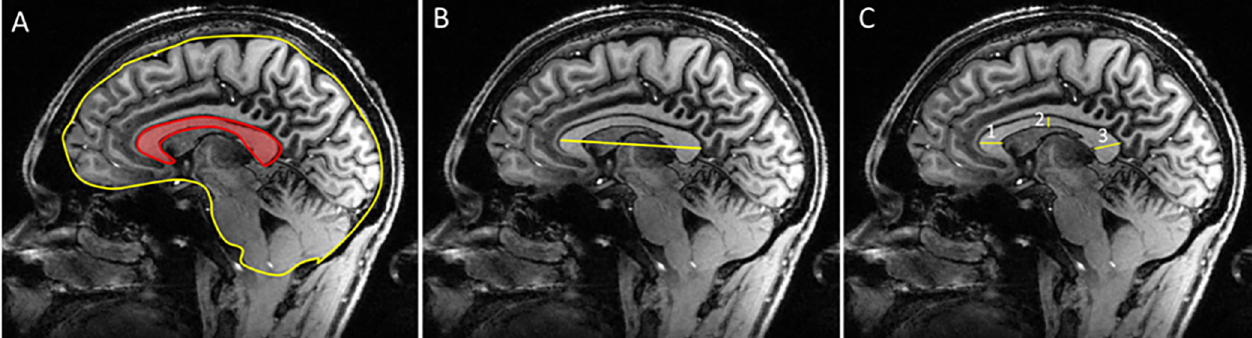
Fig 1. Delineation and partitioning of the midsagittal corpus callosum in T1-weighted MR images. The corpus callosum was traced in the three most medial brain slices. A, CC area is in red and whole skull surface is in yellow and B, length of the CC; C, CC thickness at genu, body, and splenium.